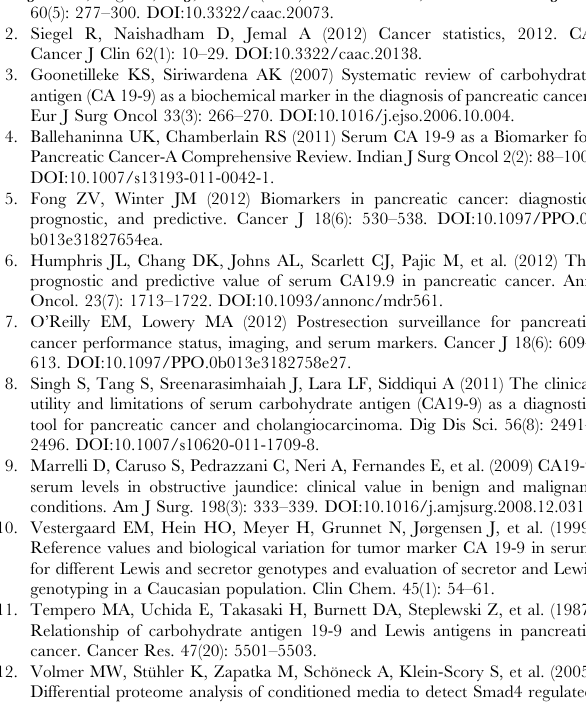
Table S4 Patient data from all ELISA samples. A) Data from cancer patients including stage, sex, age and serum levels of Fat1 and CA19-9. The CA19-9 data were generated by the medical Clinic Bochum. B) Data from all non-cancer (control) patients collected as per A). Subjects were predominantly tested for cancer but had negative diagnostic findings. Table S5 Patient data from all Tissue samples. Data from pancreatic cancer patients including stage, location of the tumor, sex and age. Normal tissue controls were from the same patients’ adjacent healthy tissue. identified in the